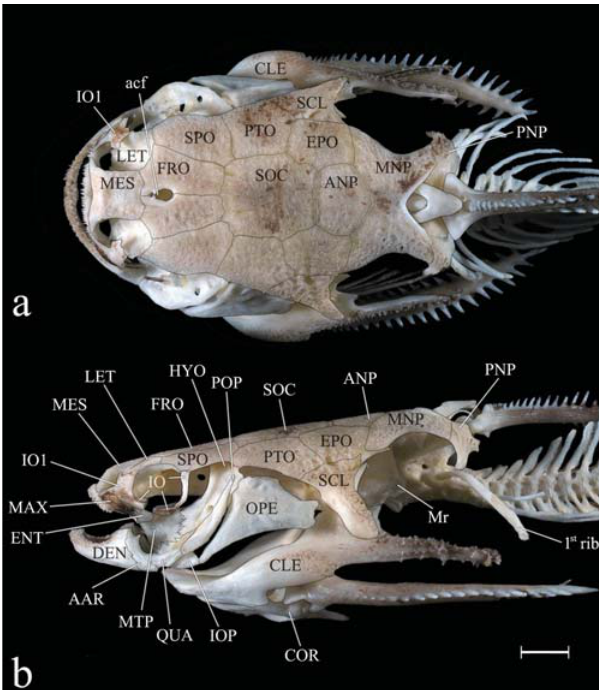
Fig. 3. Head in dorsal ( a ) and lateral ( b ) view of Liosomadoras oncinus , MZUSP 105828, 99 mm SL. AAR = angulo-articular, acf anterior cranial fontanel; ANP anterior nuchal plate, CLE = cleithrum, COR = coracoid, DEN = dentary, ENT = entopterygoid, EPO = epioccipital, FRO = frontal, HYO = hyomandibular, IO = infra-orbital, IOP = interopercle, LET = lateral ethmoid, MAX = maxilla, MES = mesethmoid, MNP = middle nuchal plate, Mr Müllerian ramus, MTP = metapterygoid, OPE = opercle, PNP = posterior nuchal plate, POP = preopercle, PTO = pterotic, QUA = quadrate, SCL = posttemporo-supracleithrum, SOC = parieto- supraoccipital, SPO = sphenotic. Scale bar = 5 mm.